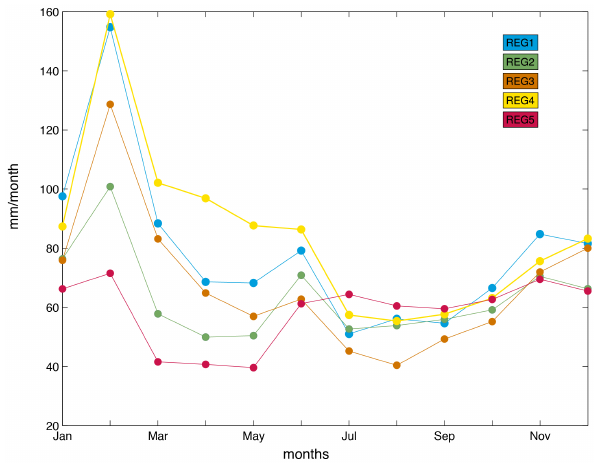
Fig. 4. Monthly climatologies of precipitation for each of the regions obtained by averaging all AWAP grid points that belong to each of the divisions.